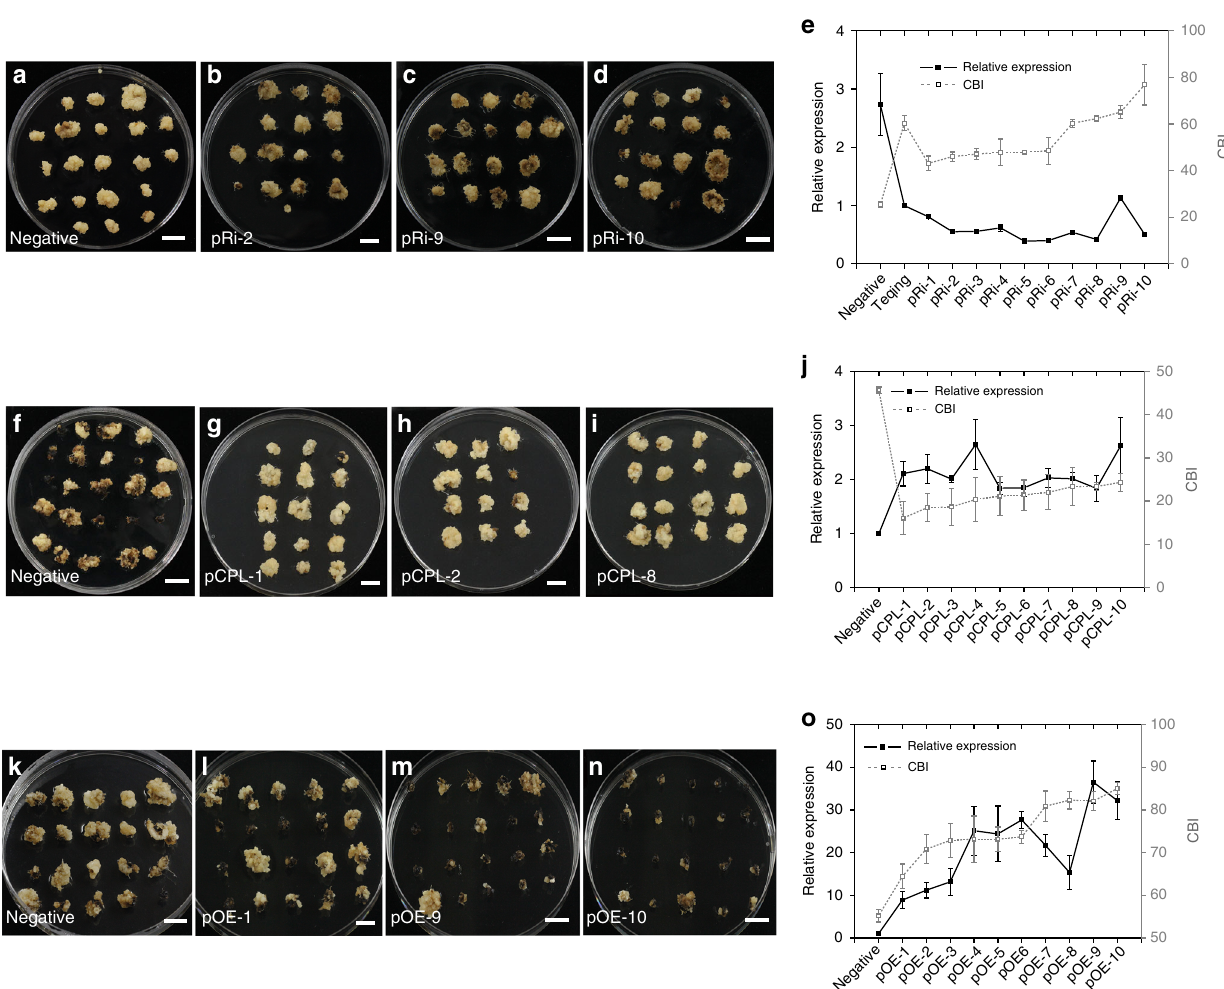
Fig. 3 Functional analysis of BOC1 . a – d Phenotypes of calli from pRi- BOC1 -YIL25 transgenic plants ( n = 18). Negative represents segregating plants from the transformation process but without the transgene. Scale bars, 1cm. e Comparison of the relative expression levels and CBI between a negative transgenic line and 10 RNAi lines ( n = 3 biological replicates). f – i Phenotypes of calli from pCPL- BOC1 -Teqing transgenic plants ( n = 15). Scale bars, 1cm. j Comparison of the relative expression levels and CBI in a negative transgenic line and 10 complementation lines ( n = 3 biological replicates). k – n Phenotypes of calli from pOE- BOC1 -Teqing transgenic plants ( n = 22). o Comparison of the relative expression levels and CBI in a negative transgenic line and 10 overexpression lines ( n = 3 biological replicates). The black line indicates the trend of the relative expression levels, and the gray line indicates the trend of the CBI. Scale bars, 1cm. Data are means±SE, two-tailed Student ’ s t -tests. Source data underlying Figs. e , j , o are provided as a Source Data fi